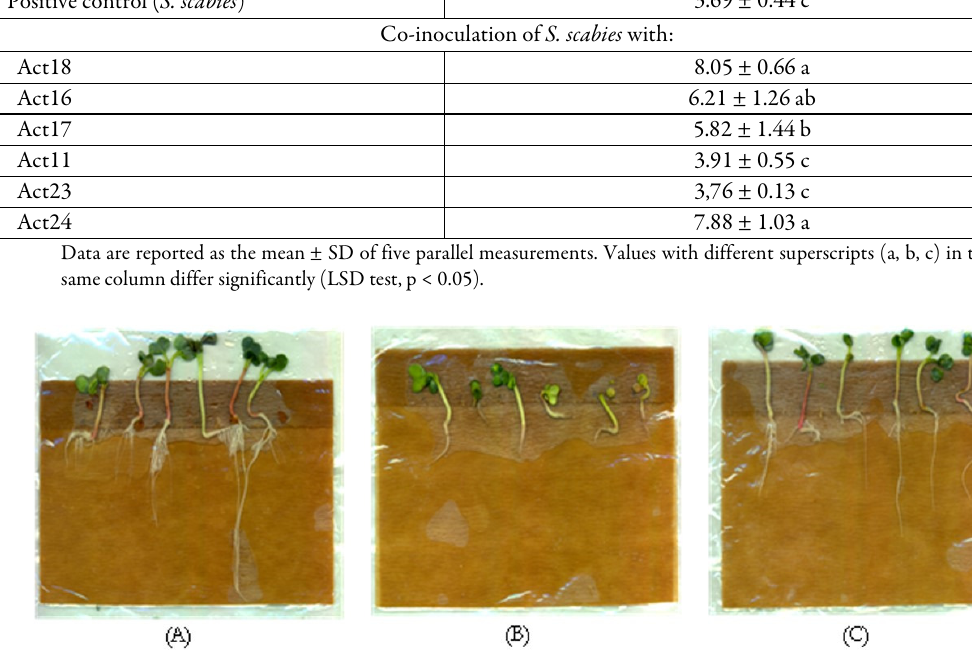
Figure 3. In vivo confrontation against S. scabies on radish seedling; (A): negative control; (B): positive control; (C): seedlings inoculation with both S. scabies and